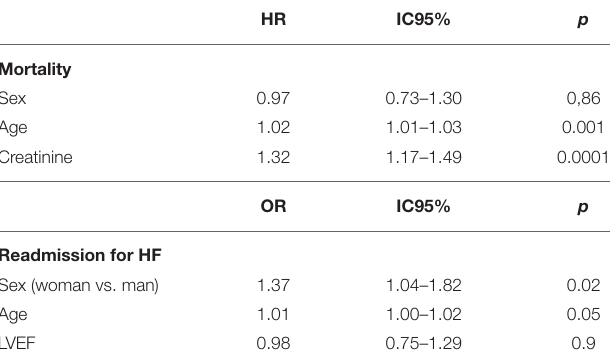
FIGURE 4 | Left: readmission rate between men and women. Right: readmission rate between men and women by LVEF. HFrEF, Heart failure with reduced ejection fraction; HFpEF, Heart failure with preserved ejection fraction. TABLE 2 | Multivariate analysis by